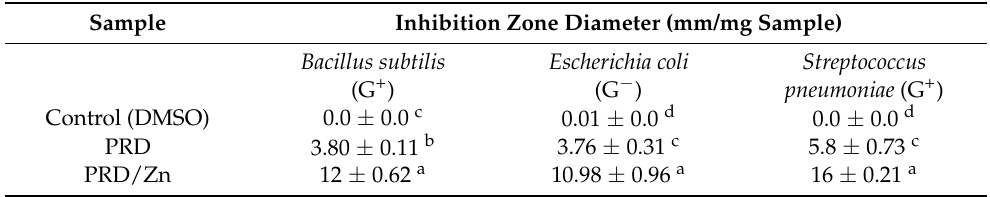
Table 4. Diameter of the inhibition zone (mm/mg sample) of the PRD and PRD/Zn metal complexes.